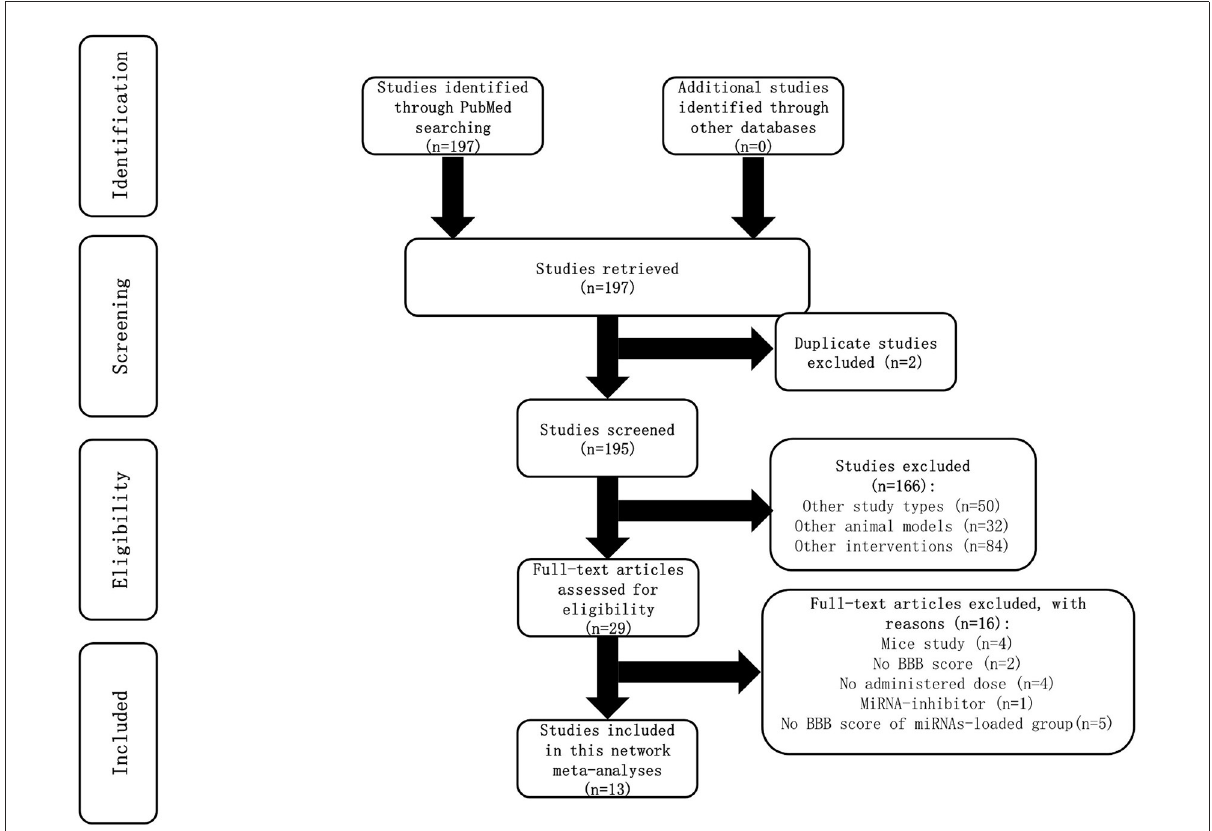
FIGURE1 Flow chart of article